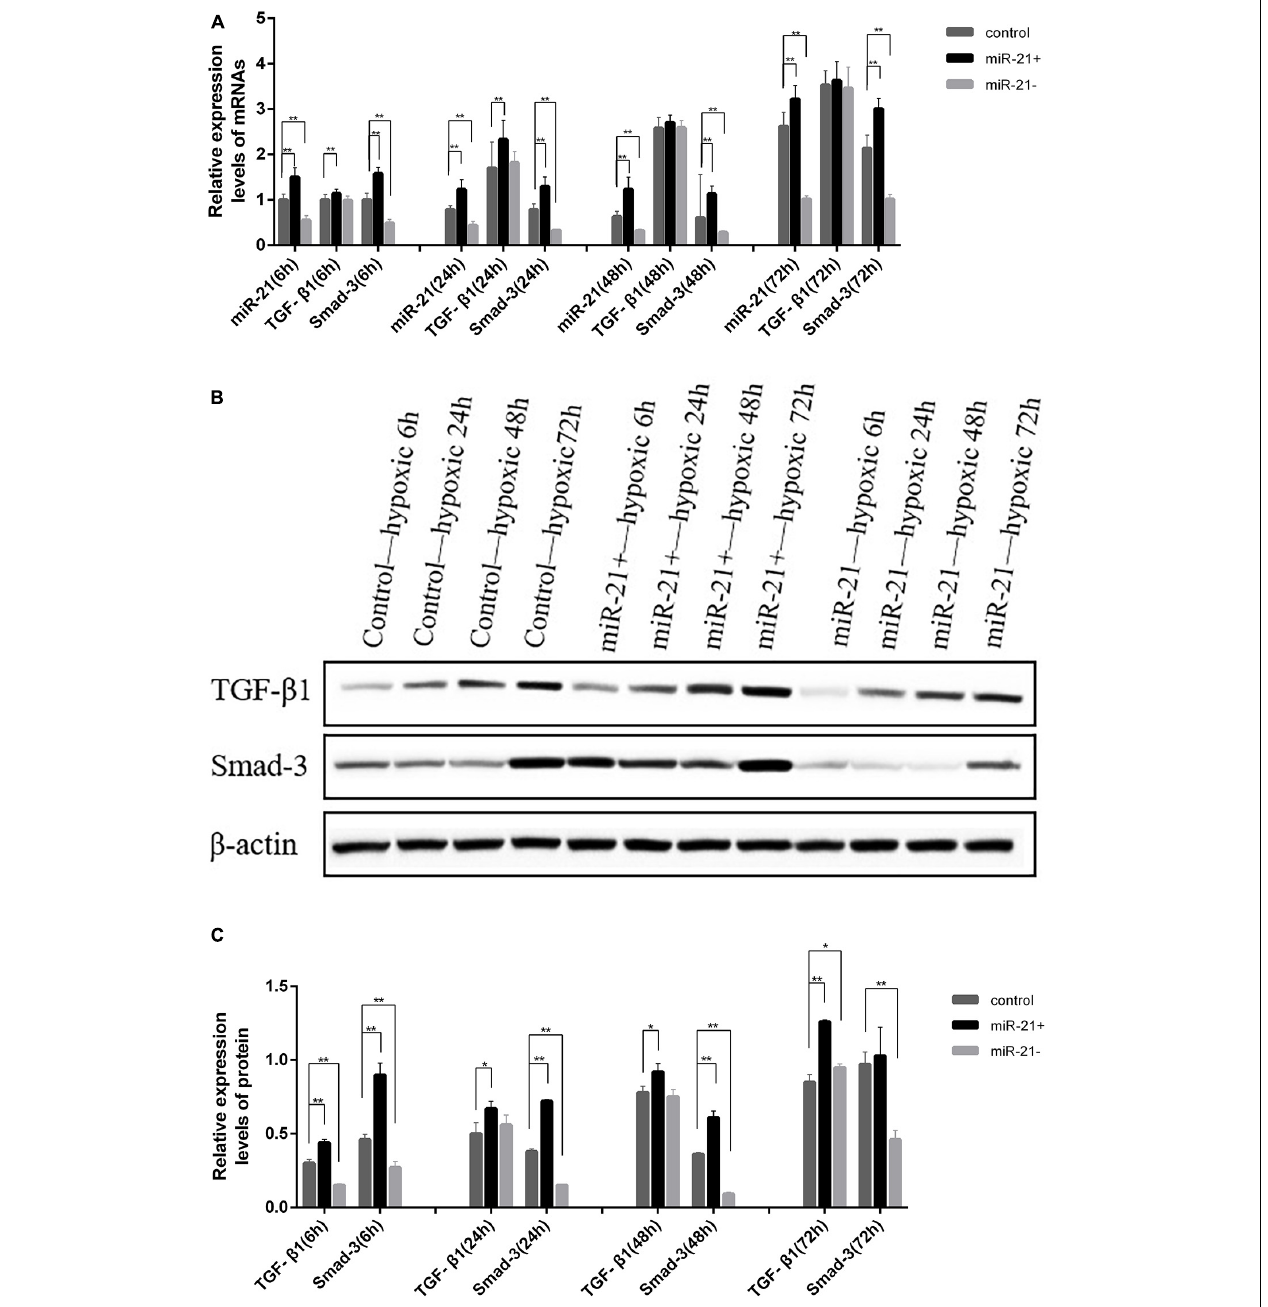
FIGURE 5 | Comparison of the expression of TGF- β 1 and Smad-3 in H9C2 cells following transfection with miR-21 mimics and miR-21 inhibitors. (A) Comparison of the expression of TGF- β 1, Smad-3, and miR-21 detected by RT-qPCR in each group; (B) Representative blot images; (C) Comparison of the expression of TGF- β 1 and Smad-3 detected by western blot analysis in each group. miR-21 +, miR-21 overexpression group; miR- 21-, miR-21 inhibition group; TGF- β 1, transforming growth factor- β 1; * P < 0.05 compared with the blank group; ** P < 0.01 compared with the blank